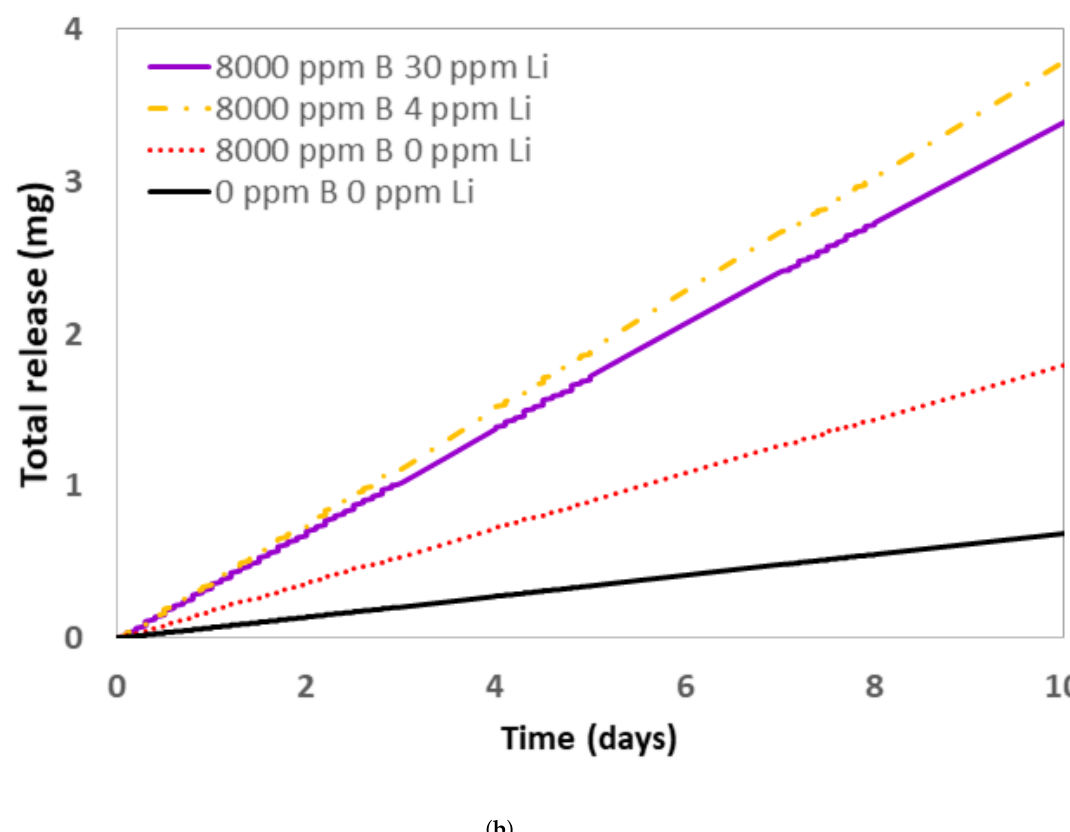
Figure 8. Surface of a stainless steel tube exposed to borated water solutions simulated using PACTITER 2.1 (elements considered are Fe, Ni, Mn, Co, and Cr): ( a ) total mass deposit and ( b ) metal